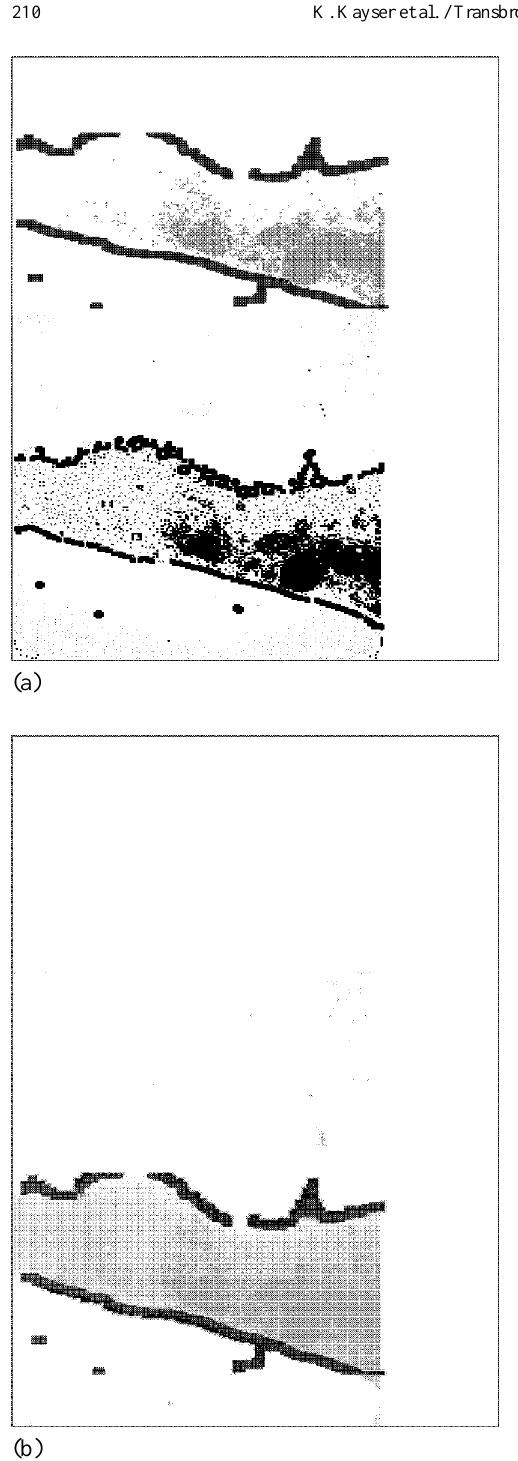
Fig. 3. Selection of diagnostic important area by gray value thresh- olds. The upper compartment displays the boundary and the density of atypical cells, the lower one the calculated center (in green color) of a potential automated sampling procedure.